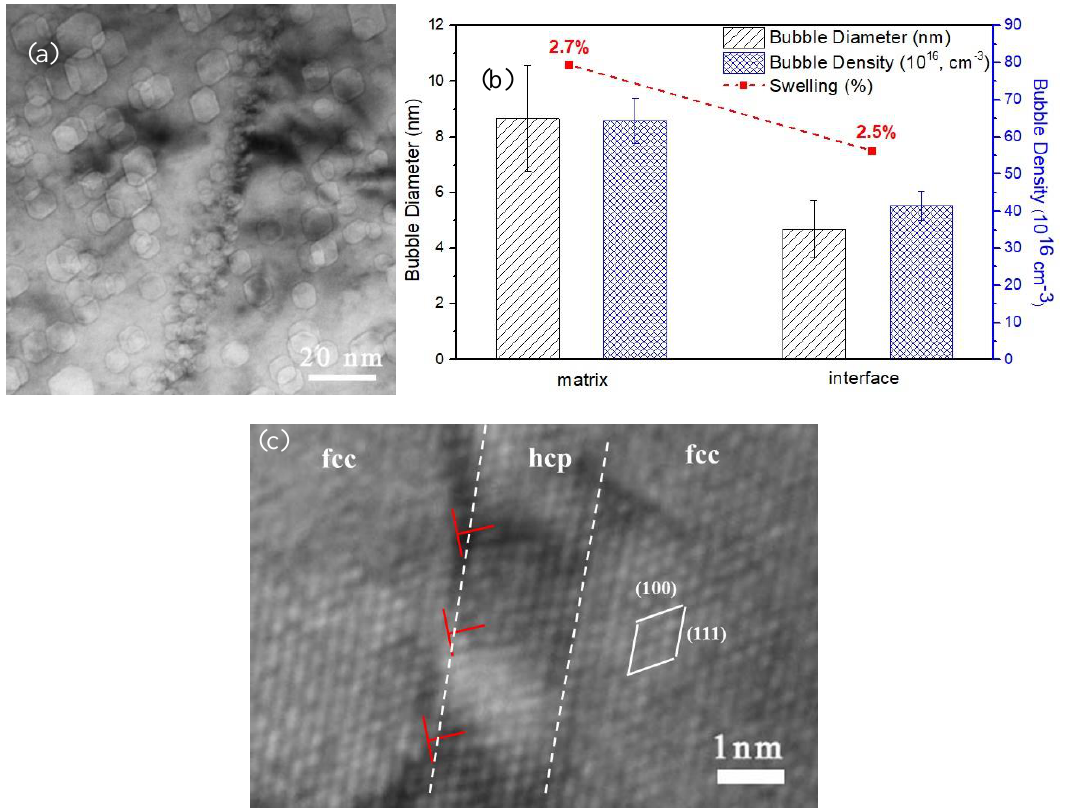
Figure 11. TEM micrograph ( a ) and statistical data ( b ) for the helium bubbles along the fcc–lamellae hcp boundary, including the helium bubble size, helium bubble density, and bubble swelling. ( c ) High-resolution TEM confirms the presence of coherent phase boundaries between the hcp and fcc phases.